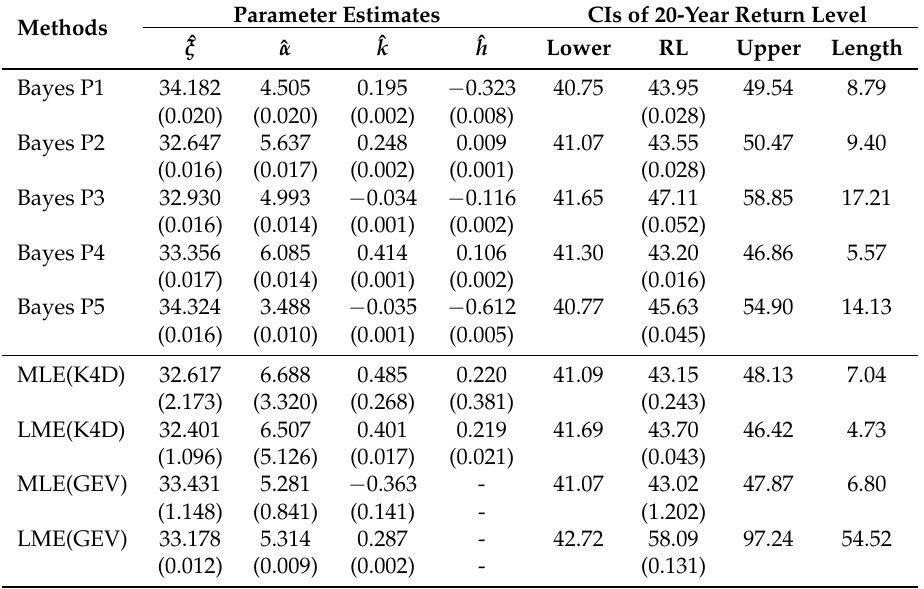
Table 1. Comparison of the estimates of the K4D and the standard errors in parentheses obtained by the MLE, L-moments, and Bayesian methods with the five priors (P1–P5) considered in the Section 4.2 and the confidence intervals (CI) of the 20-year return level (RL) for the annual maximum wind speed data (unit: km/h) at Udon Thani, Thailand, 1990–2015. The posterior mean and the credible (highest posterior density) interval are obtained for the Bayesian estimates.